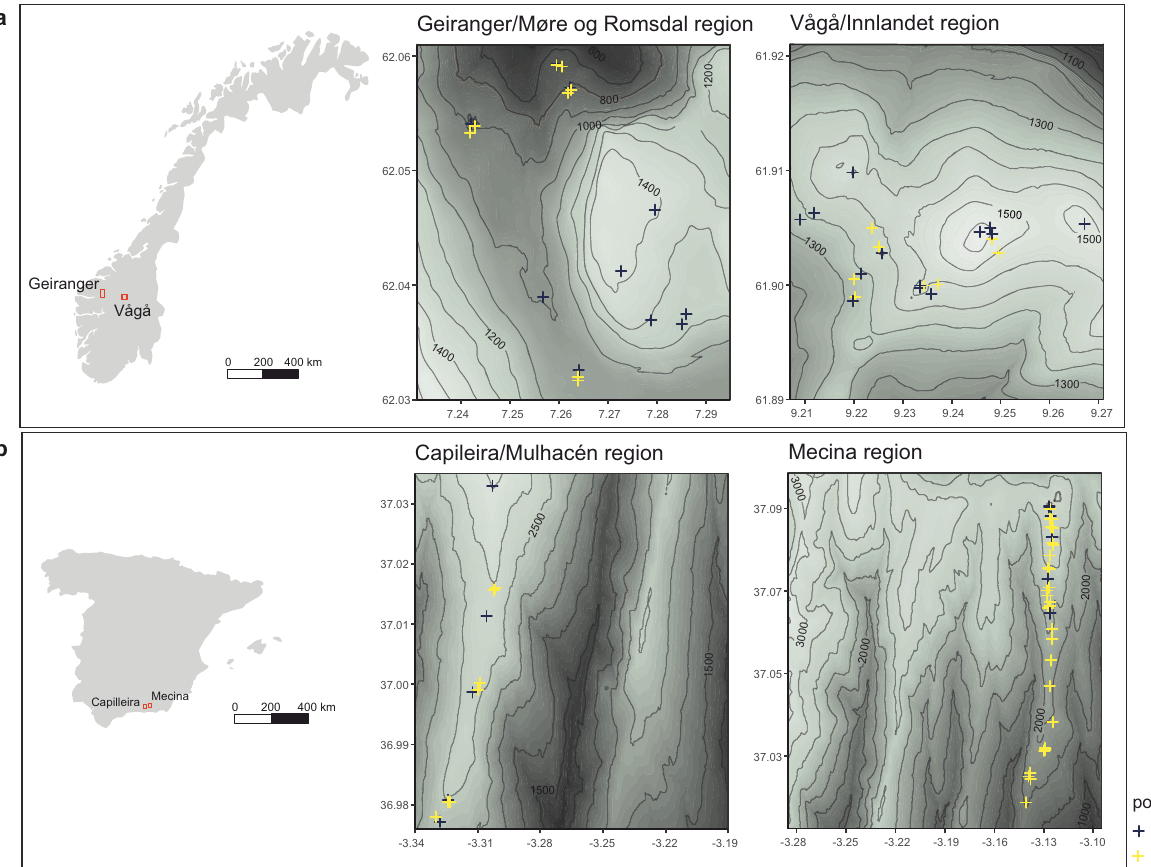
Fig. 1 Study regions and location of study sites. The four study regions and their location in Norway ( a ) and Spain ( b ). Data source for the elevation models: Norway 75 , Spain 76